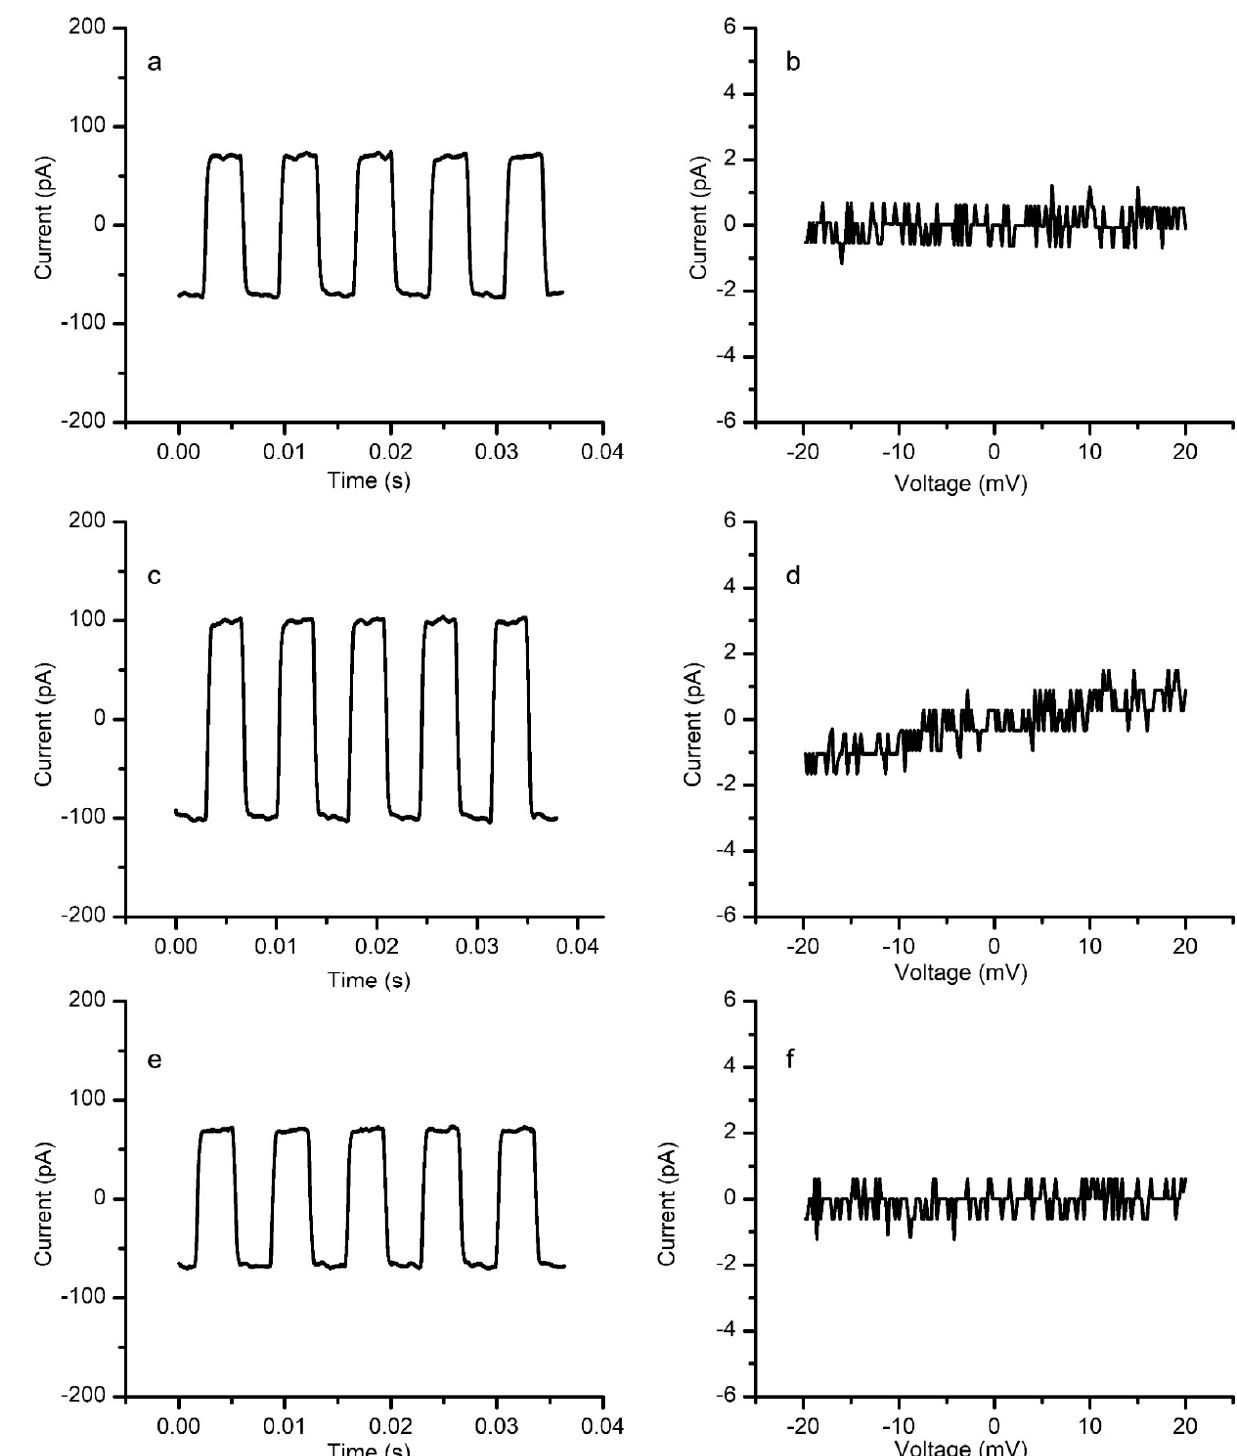
Figure 4. Preliminary testing of the experimental system on a cholesterol-free membrane. A relaxed membrane has a capacitance of ~70 pF ( a ) and a very low conductance ( b ). Pressure from the additional solution in the grounded reservoir leads to an increase in capacitance ( c ) and conductance (the slope of the IV plot) ( d ). The elimination of the differential pressure by solution removal restores the initial capacitance ( e ) and conductance ( f ).